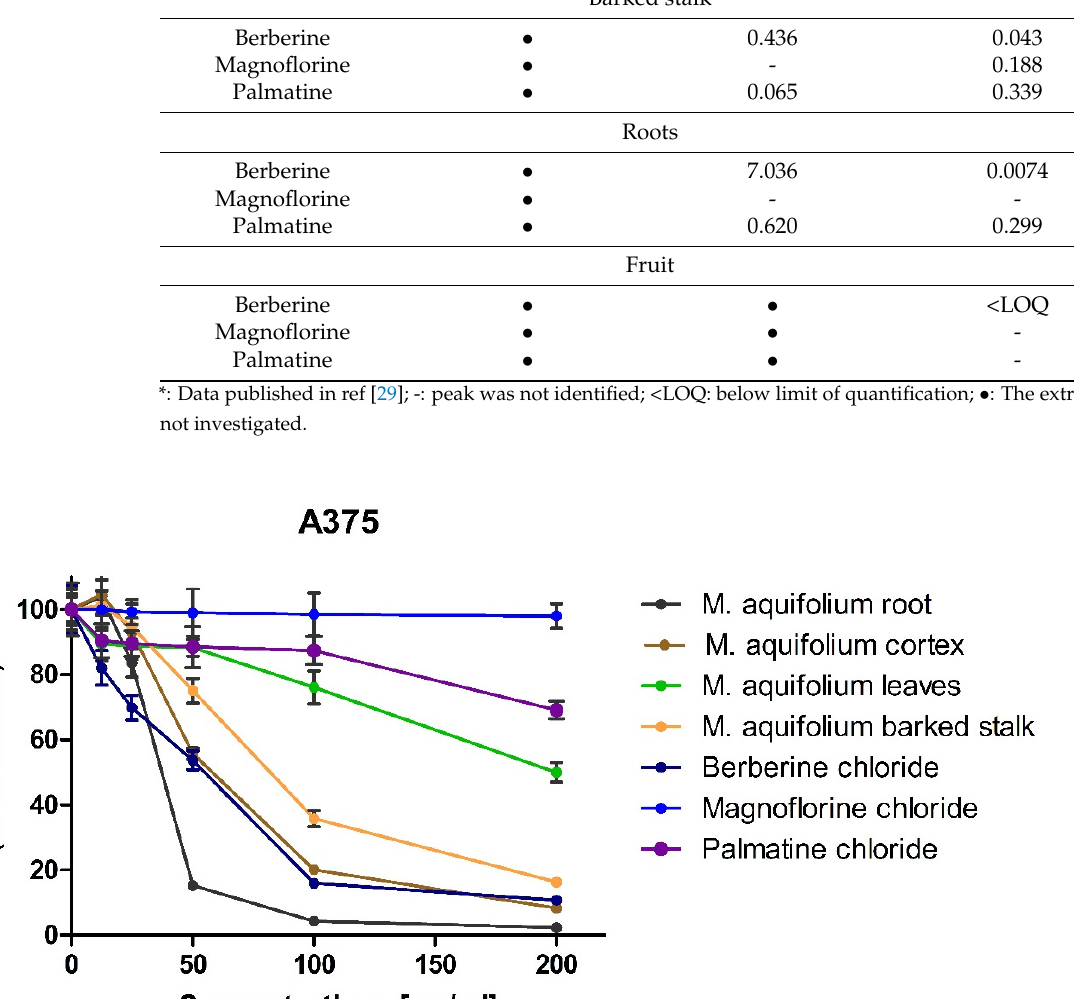
Table 3. Cytotoxic activity, expressed as IC 50 values, of the investigated extracts and alkaloid